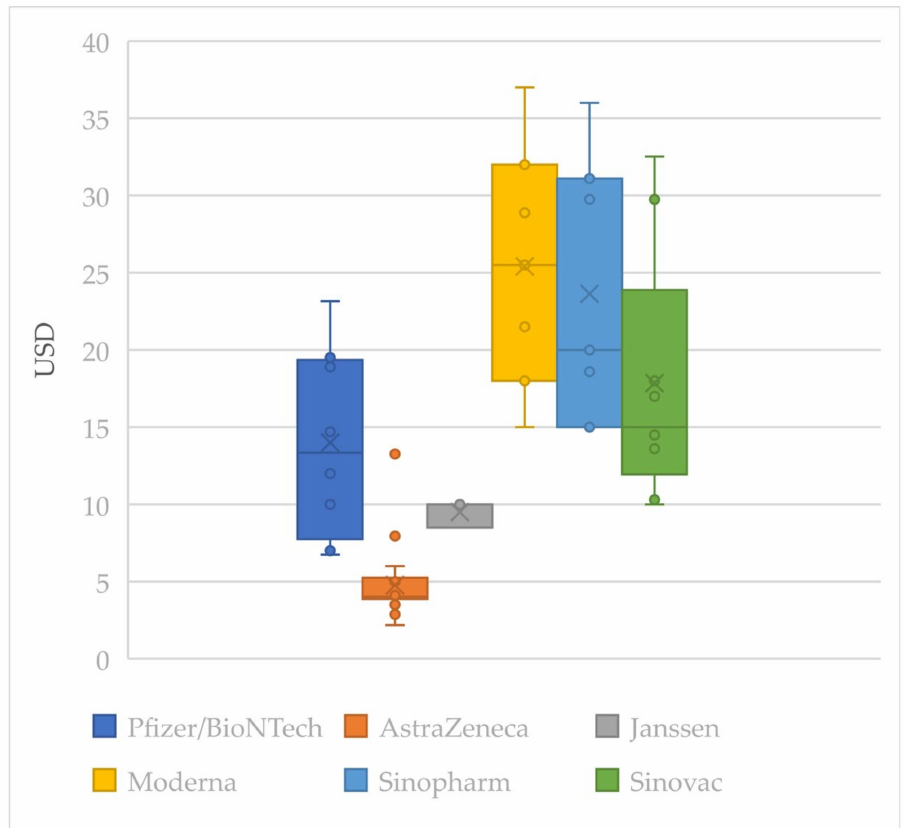
Figure 1. Box-and-whisker diagram of vaccine prices by